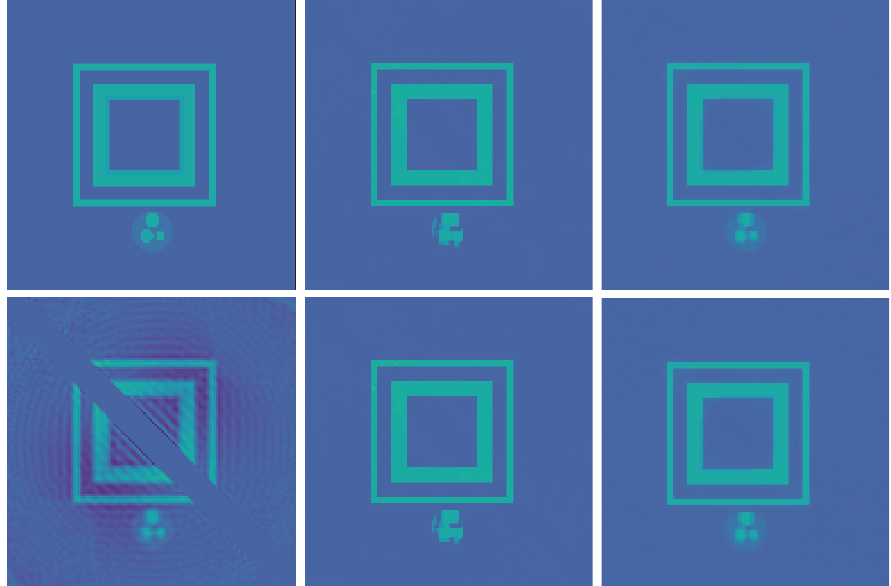
Figure 4. Left column: phantom with a structure not contained in the training data ( top ) and pseudo inverse reconstruction ( bottom ). Middle column: Post-processing reconstructions with Φ ( 3 ) using exact ( top ) and noisy data ( bottom ). Right column: NETT reconstructions with and noisy data ( bottom